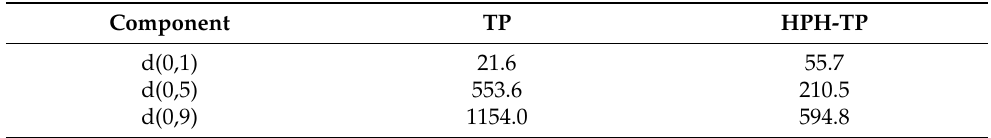
Figure 8. Particle size distribution of cellulose isolated from tomato pomace (TP) and high-pressure homogenized tomato pomace (HPH-TP) through the mild chemical hydrolysis cascade process. Table 4. Characteristic percentile diameters ( µ m) of the cumulative size distribution of cellulose isolated from tomato pomace (TP) and high-pressure homogenized tomato pomace (HPH-TP) through the mild chemical hydrolysis cascade